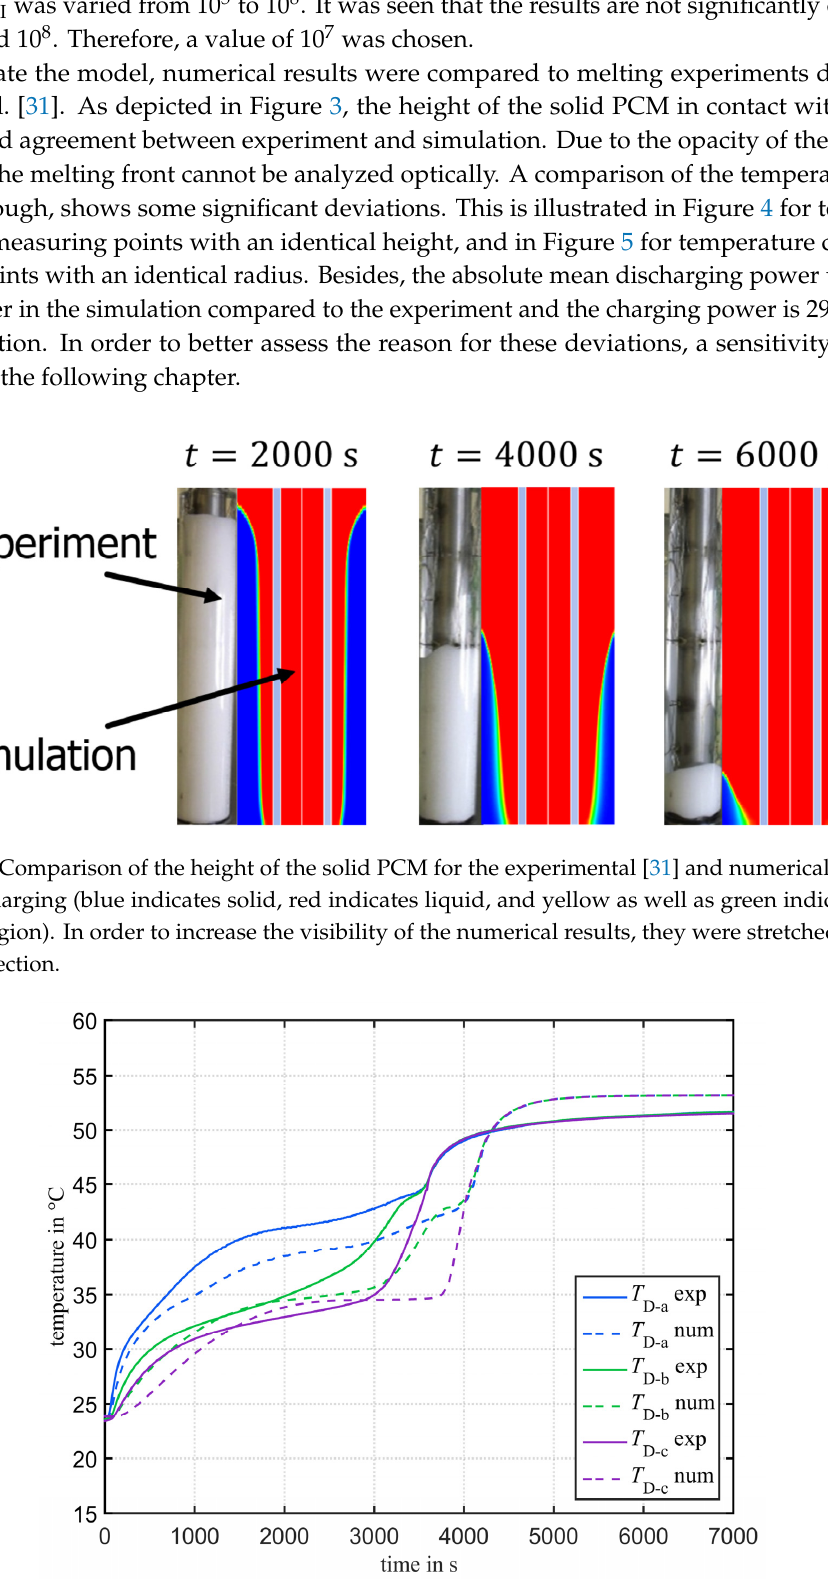
Figure 4. Comparison between experiment (exp) and standard simulation (num) for temperature curves during charging of measurement points with an identical height.